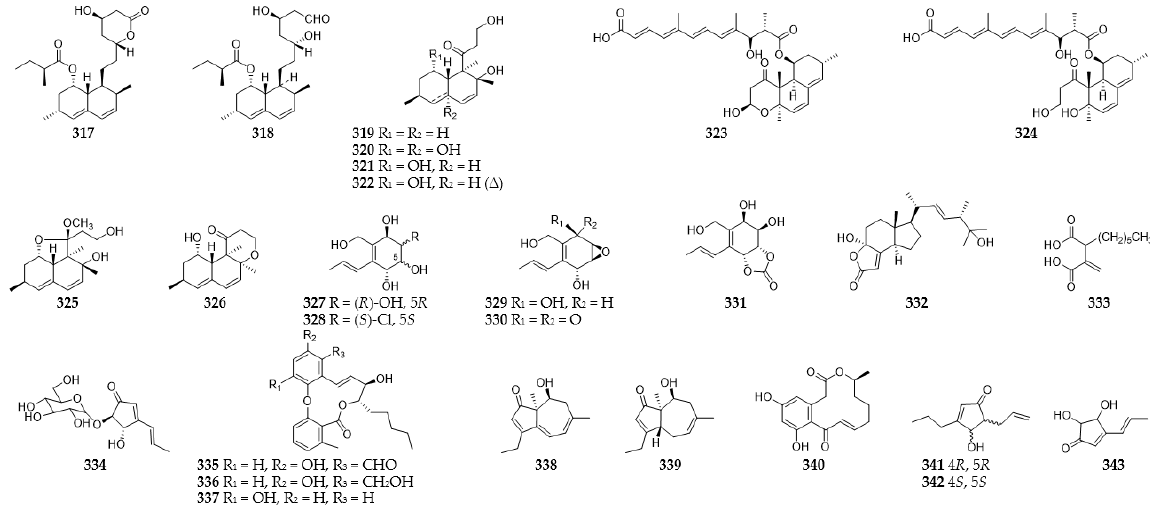
Figure 20. Aspergillus -derived miscellaneous compounds ( 317 – 343 ). A terrein glucoside ( 334 ) was a new angiogenin secretion inhibitor produced by strain A. sp. PF1381 [155]. Bioassay-guided isolation of an extract of A. sp. MF6215 led to the discovery of three novel 11-membered macrocyclic biphenyl ether lactones ( 335 – 337 ), in which compound 335 inhibited the IgE binding to its receptor by an IC 50 value of 200 µ M [156]. By UHPLC-DAD-HRMS and dereplication, aculenes C and D ( 338 and 339 ) were isolated from a strain of A. aculeatus but showed weak antifungal activity [150]. Dehydrocurvularin ( 340 ) was a new lactone polyketide from strain A. terreus ATCC 20542 and acted as a prevalent fungal phytotoxin with heat shock response and immune-modulatory activities and a broad-spectrum inhibitor of various cancer cell lines in vitro [61,157,158]. Aspergones G and H ( 341 and 342 ) produced by the strain A.